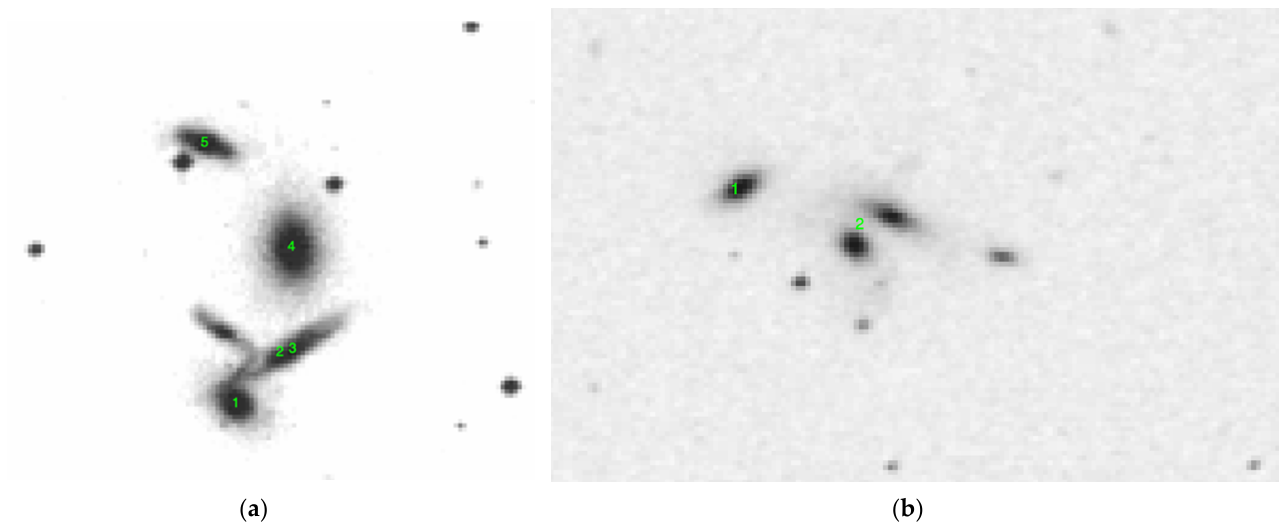
Figure 7. ( a ) DSS image of HCG 40 with X-ray point sources. ( b ) DSS image of HCG 6 with X-ray point sources.